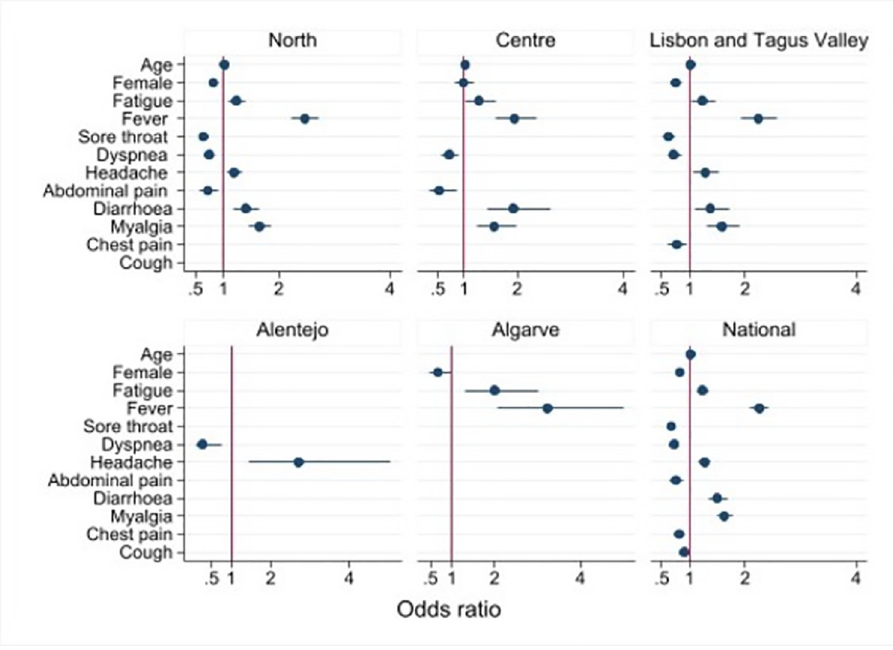
Fig 2. Predictors and 95% confidence intervals of SARS-CoV-2 virus test positivity using multivariate analysis, at the national level and by health region, among suspected cases of COVID-19, March-April 2020, (N = 25,926). Estimates for some predictors are missing because those were not retained by the model using a backwards stepwise model selection.